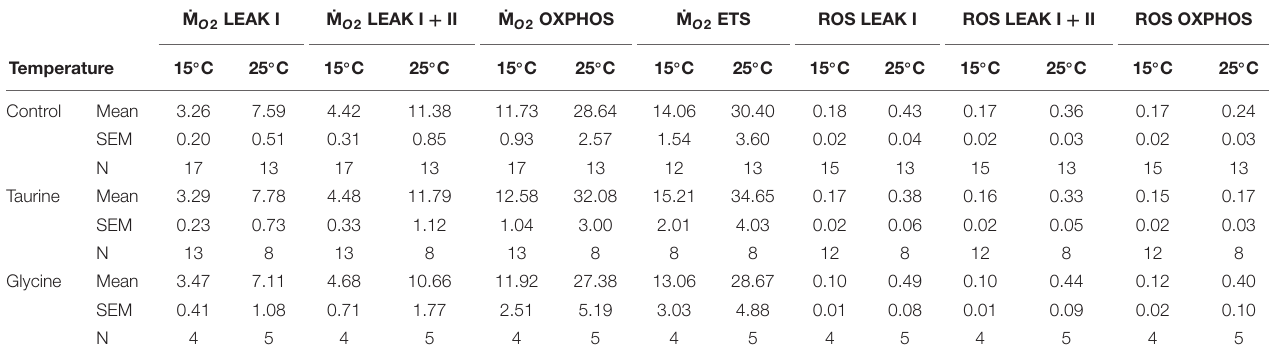
TABLE 1 | Effect of amino acid addition (50 mM taurine or glycine) on oxygen consumption ( ˙M O 2 ) and ROS efflux of isolated mitochondria of M. edulis. ˙M O 2 LEAK I